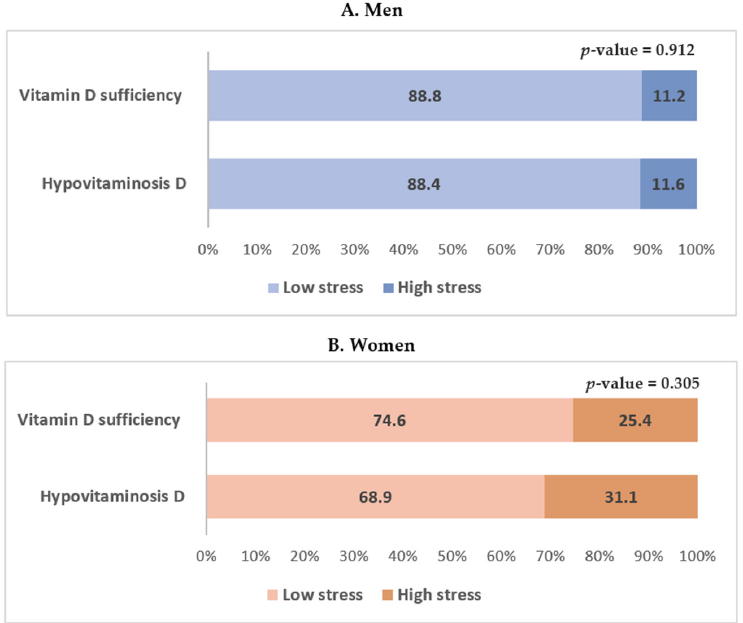
Figure 3. Serum 25-hydroxyvitamin D level according to perceived stress status in men and women. Data are presented as estimated means (%). p -values were obtained by Pearson’s chi-squared using a complex sample design. Table 4. Odds ratios (95% confidence intervals) of perceived stress status according to vitamin D levels.